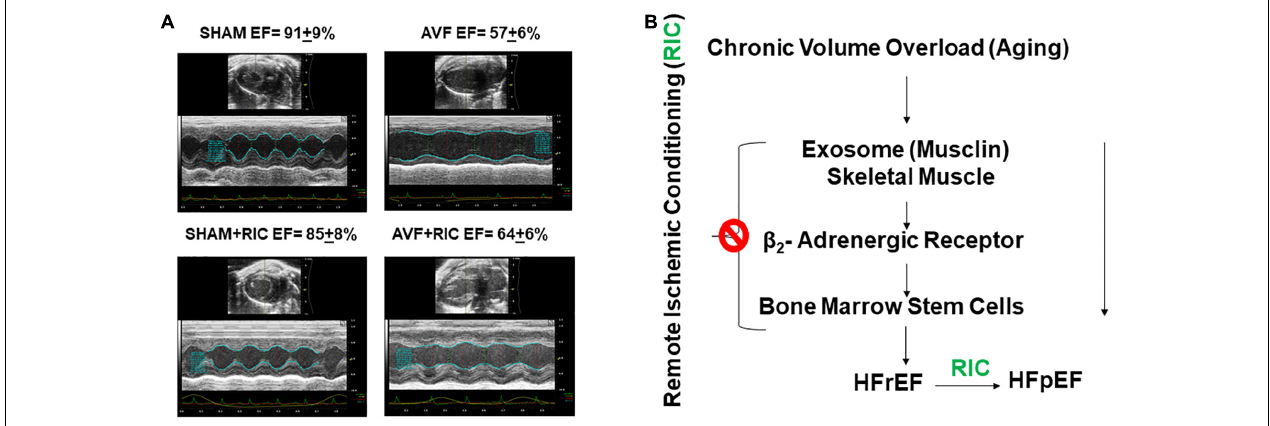
FIGURE 7 | (A) The representative echocardiography and ejection fraction (EF) of sham and AVF hearts from mice treated with and without RIC. (B) HFrEF is caused by decreases in skeletal muscle myokine and RIC stimulates the exosome from skeletal muscle and mitigates